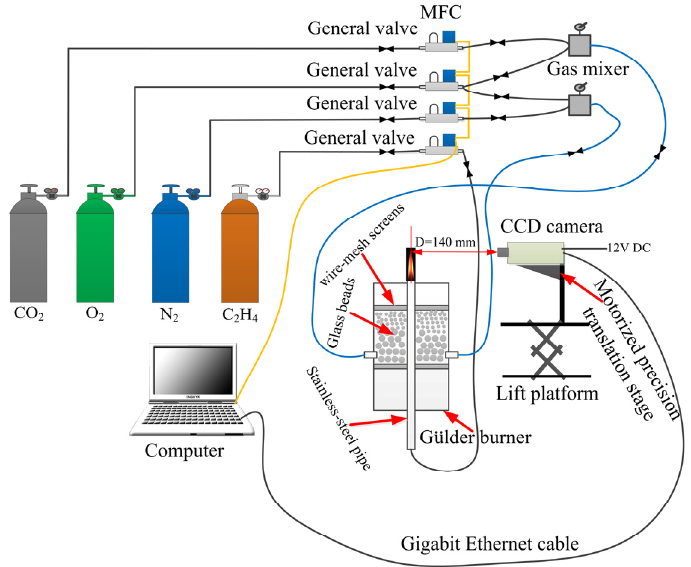
Figure 5. Schematic of the experimental equipment and the burner.